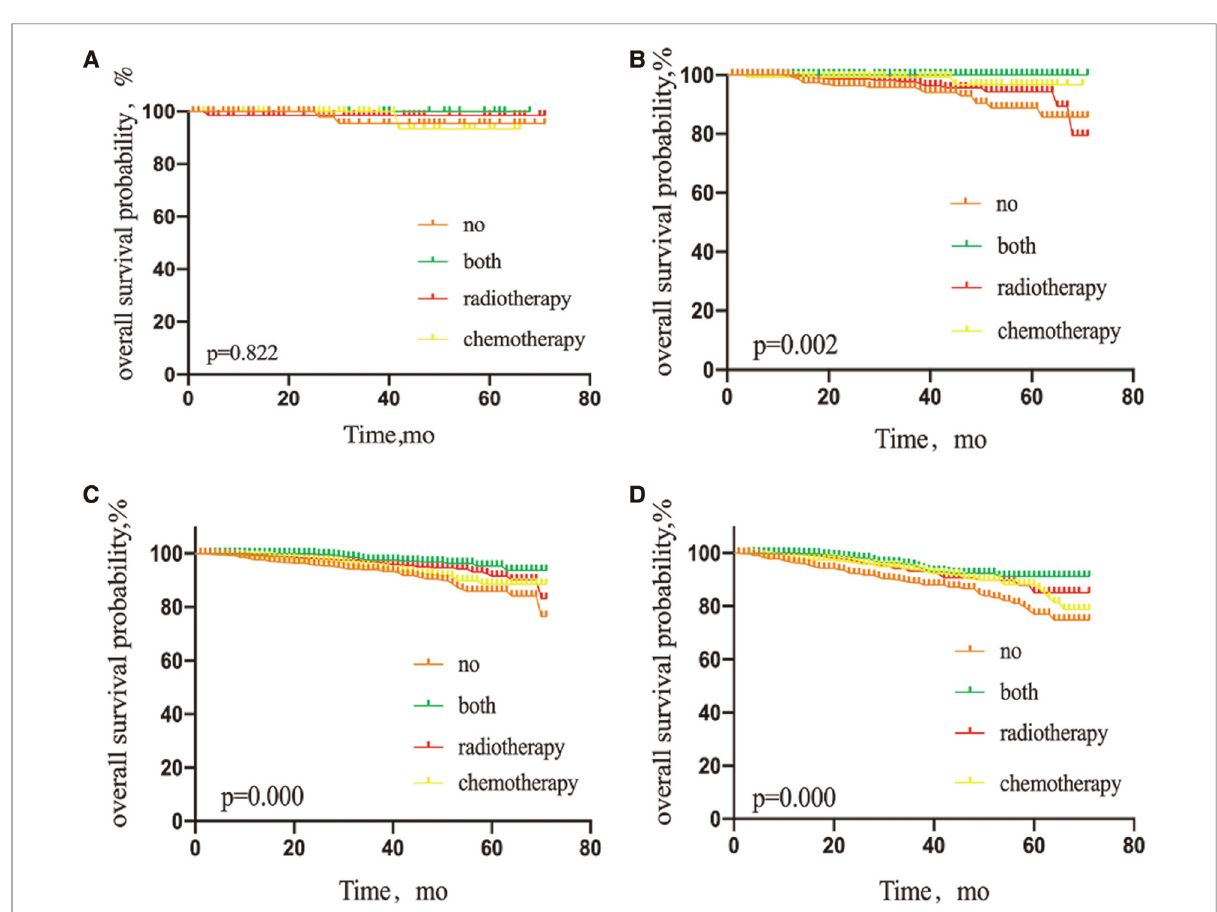
FIGURE 6 Kaplan – Meier curves depicting overall survival between treatment arms in patients with T1a stage ( A ), T1b stage ( B ), T1c stage ( C ), or T2 stage ( D ) breast cancer with sentinel lymph node micrometastases. NO patients treated with no adjuvant therapies; BOTH patients treated with both adjuvant chemotherapy and radiotherapy; RADIOTHERAPY patients treated with adjuvant radiotherapy; CHEMOTHERAPY patients treated with adjuvant